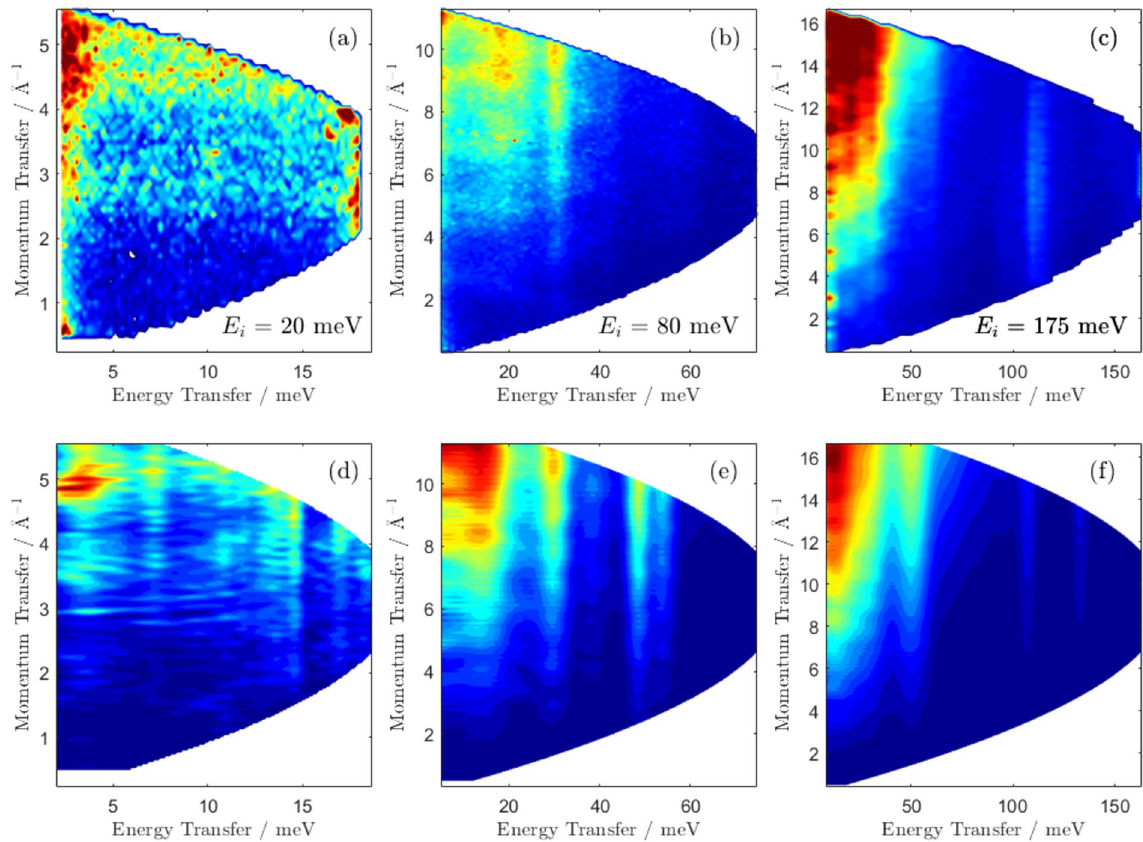
Figure 2. Neutron dynamic structure factor of anhydrous UO 2 F 2 . Top panel: Measured S Q ( , ) ω for ( a ) 20, ( b ) 80, and ( c ) 175 meV incident energy neutrons. Bottom panel: Predicted ω S Q ( , ) modeled for ( d ) 20, ( e ) 80, and ( f ) 175 meV incident energy neutrons. In the calculation, the estimated energy resolution is modeled according to the known instrument geometry, moderator emission time, and chopper rotation frequencies and a Gaussian broadening is applied. The calculated result is binned in the same binning as the data itself (0.08, 0.1, and 0.2 meV bins), which is narrower than the spectrometer’s energy resolution for the given incident neutron energies (approximately 0.5, 2, and 4 meV at the elastic line for 20, 80, and 175 meV incident energy). Low energy phonon modes are observable below 50 meV, with O–U–O stretching vibrations around 110 meV. The modeled data predicts stronger phonon scattering near 50 meV than is observed, which is related to H coupling as discussed in the